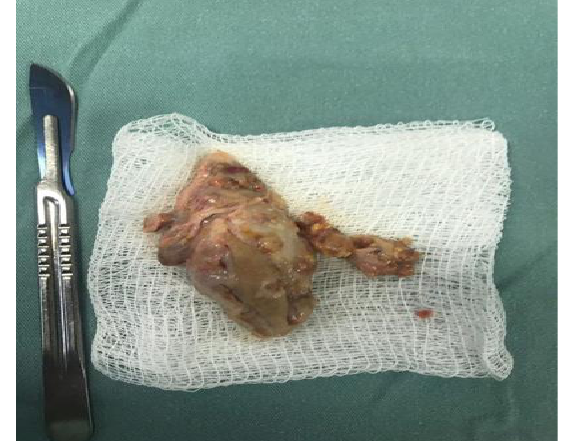
Figure 2. Macroscopic piece demonstrating